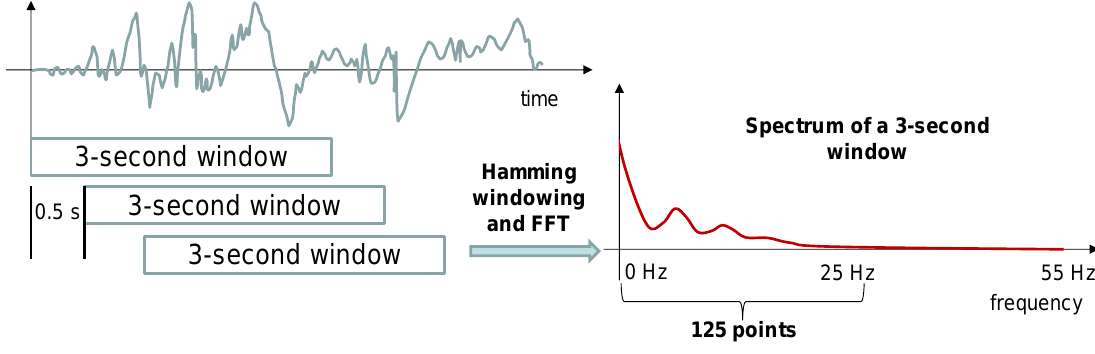
Figure 2. Signal preprocessing carried out for every time-series.